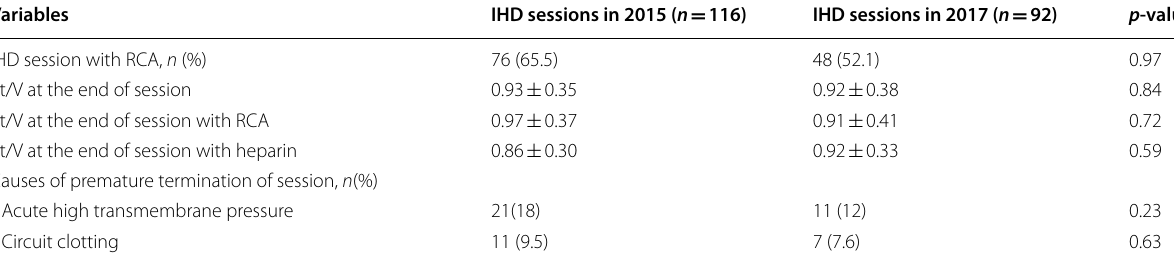
RCA, regional citrate anticoagulation, IHD, intermittent hemodialysis